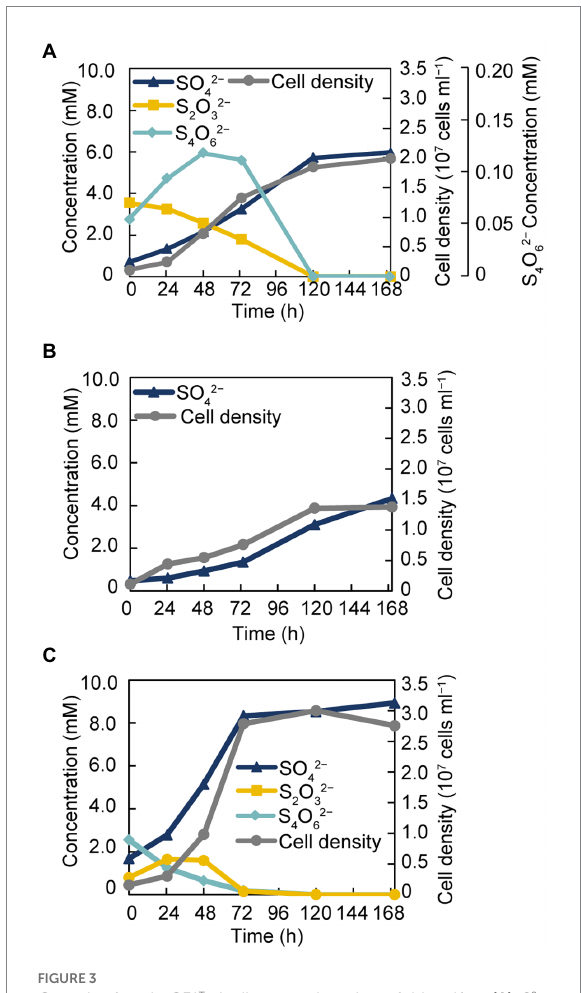
FIGURE 3 Growth of strain GF1 T via disproportionation of thiosulfate (A) , S 0 (B) , and tetrathionate (C)